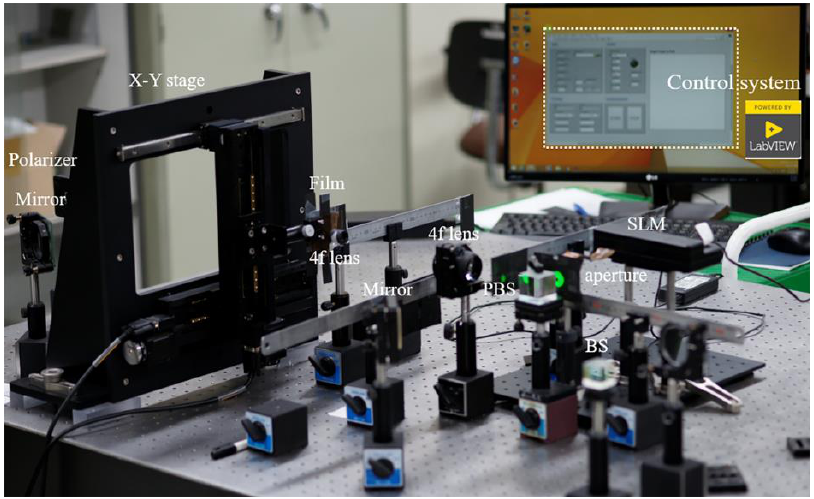
Figure 10. Photograph of holographic stereogram printing.